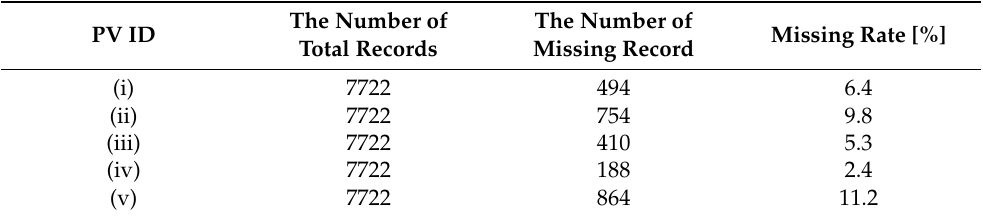
Table 1. The ratio of the missing records for each PV in all past data.